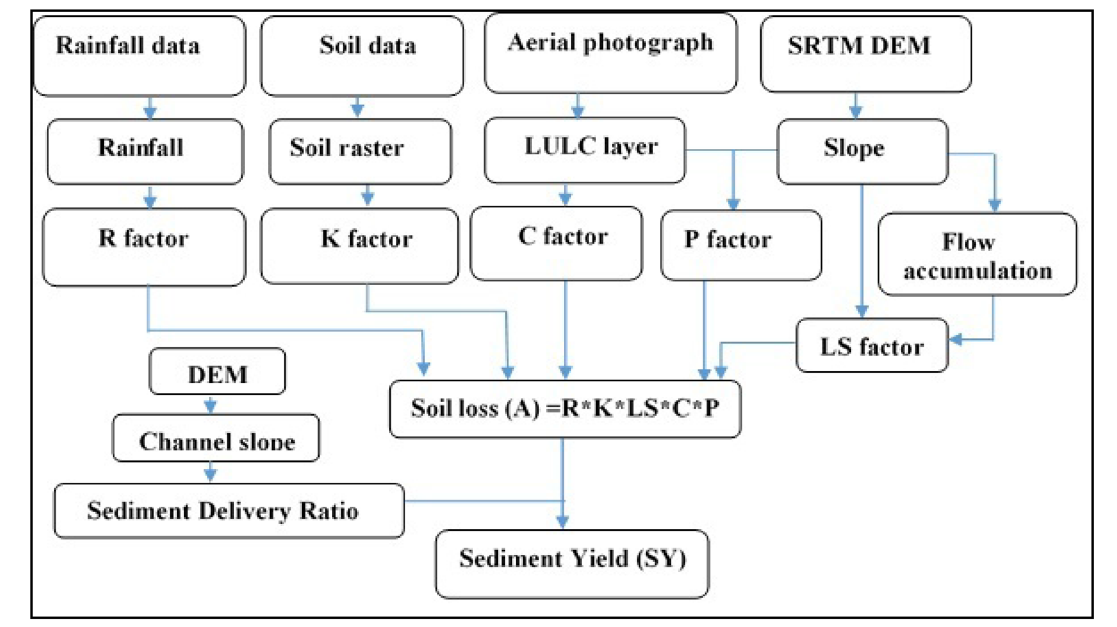
Fig. 2 Schematic representation of methods